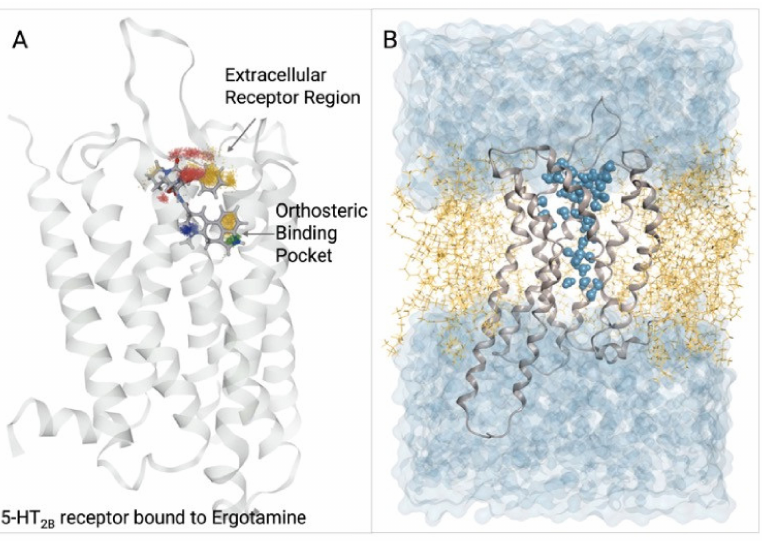
Figure 4. ( A ) Dynamic interaction pattern of the β -arrestin-biased ligand Ergotamine within the 5-HT 2B receptor, derived via MD simulation and subsequent application of the dynophore method (https://github.com/wolberlab/dynophores, accessed on 8 July 2022). The interaction pattern indi- cates a stable binding pose within the orthosteric binding pocket, visualized as spherical distribution of the point density clouds, and a more flexible interaction pattern within the extracellular receptor region [133]. Yellow = lipophilic contact, red = hydrogen bond acceptor, green = hydrogen bond donor, blue = positive ionizable area. ( B ) Time frame snapshot of the 5-HT 2B receptor (grey) derived from MD simulation within a box of water molecules (light blue surface) and embedded into a mem- brane (yellow). The movement of water molecules within the receptor binding site (cyan spheres) during MD simulations can be traced by the open-source software Pyrod [134] which analyzes their interaction patterns to derive 3D pharmacophore features (https://github.com/wolberlab/pyrod, accessed on 24 June